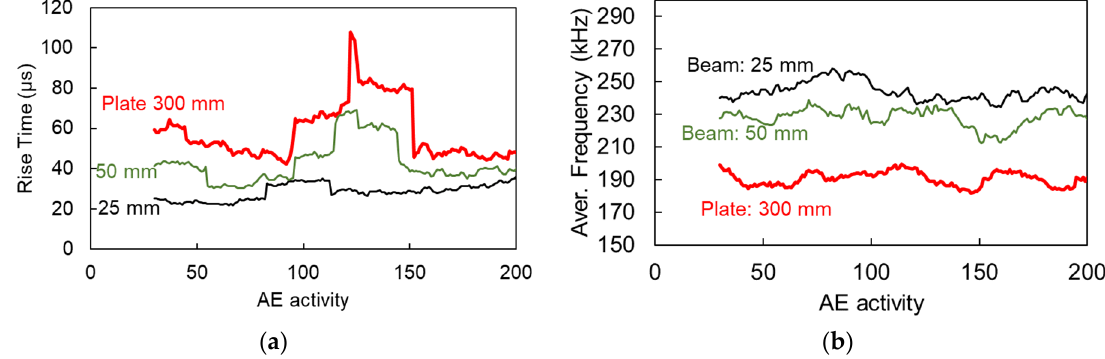
Figure 8. Sliding average of the rise time ( a ) and AF ( b ) for the first 200 hits in specimens with different widths (sliding window of 30 points).